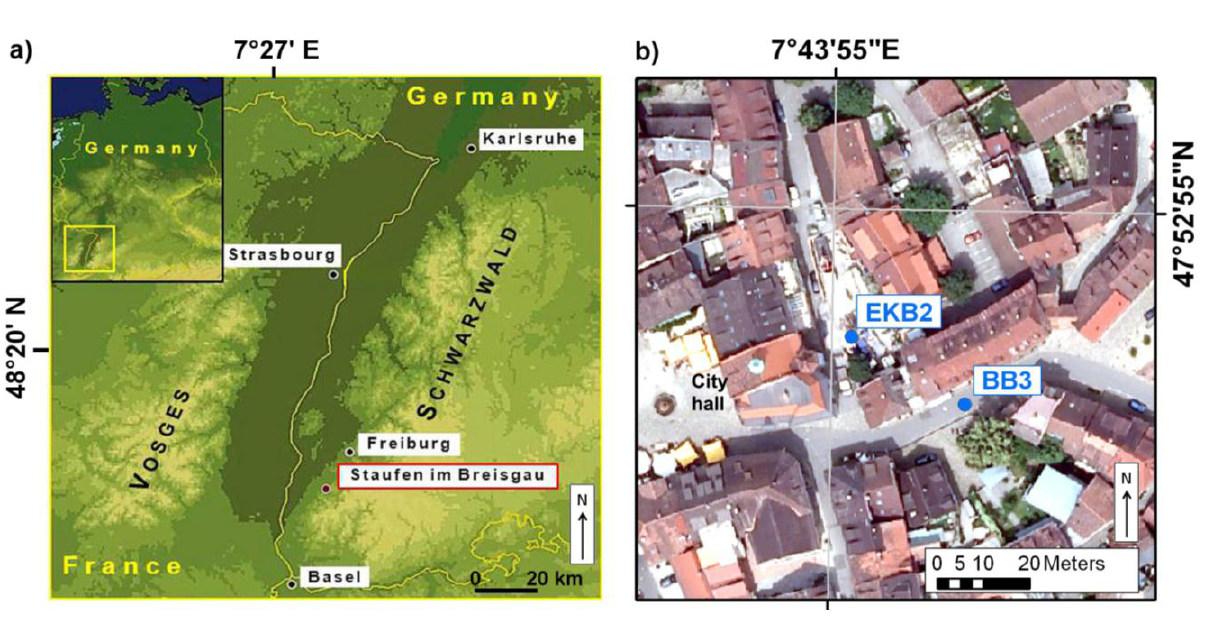
Figure 1. ( a ) Location of the city Staufen im Breisgau; ( b ) Sketch of well locations EKB2 and BB3 that are currently used for ground water pumping. An orthophoto was used as background (acquired by State Survey Office of